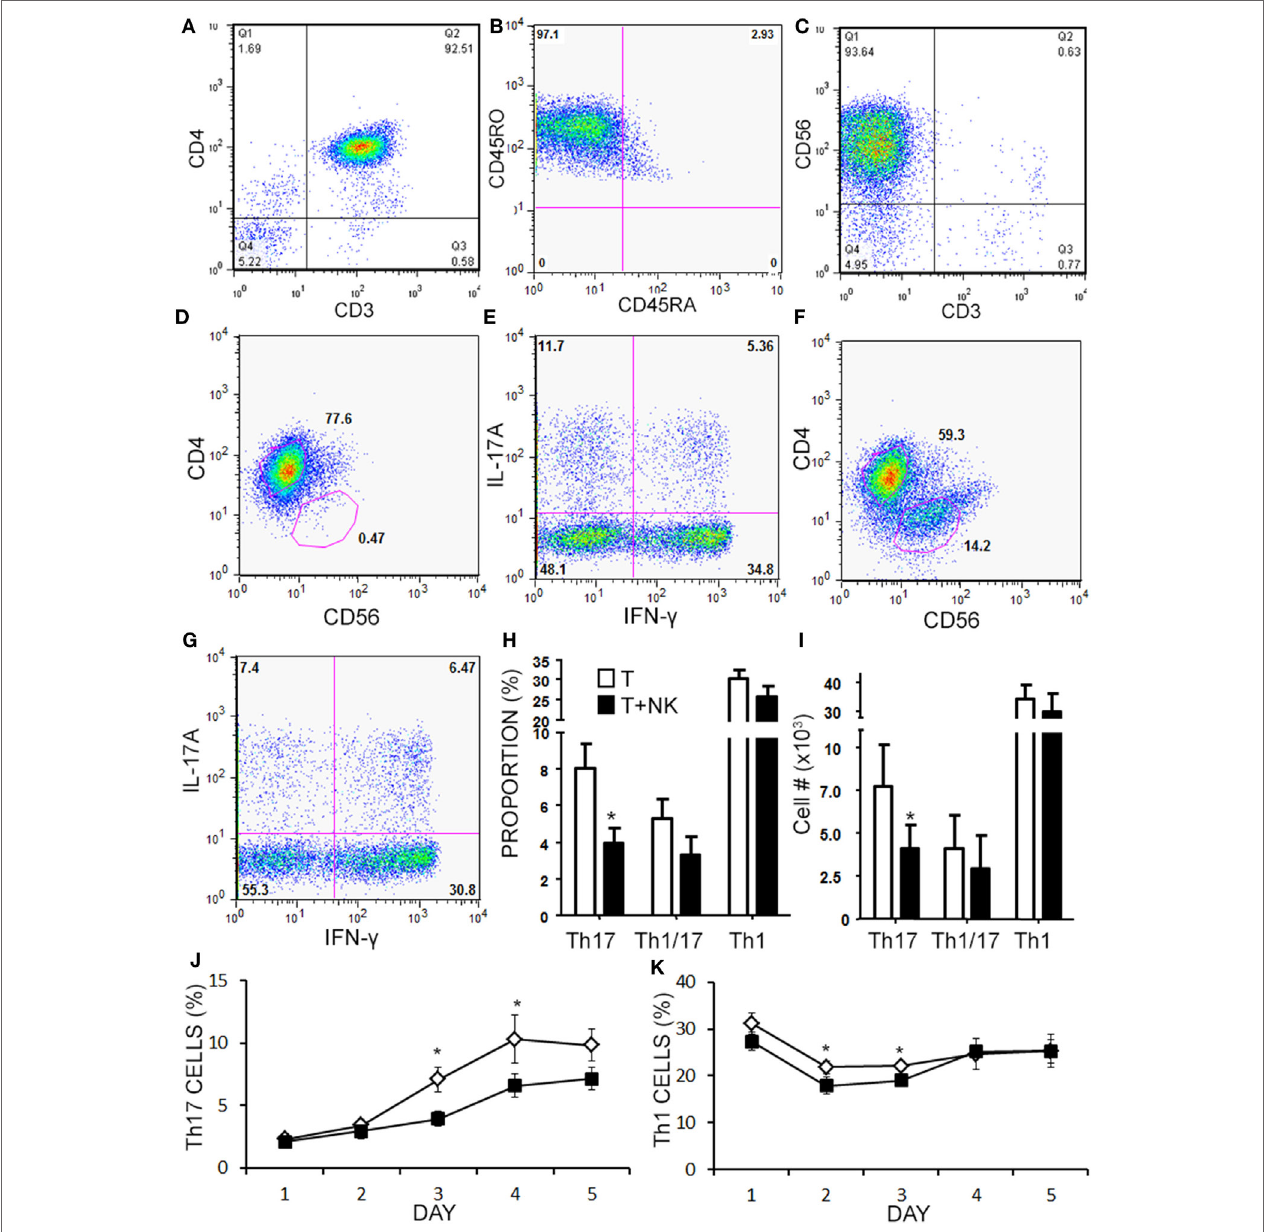
FigUre 5 | Natural killer (NK) cells reduce the proportion of Th17 and Th1 cells in vitro . Memory CD4 + T cells and NK cells were isolated from healthy subject PBMC. Memory CD4 + T cells were CD3 + CD4 + CD45RO + CD45RA − as shown in representative dot plots (a,B) . NK cells were CD3 − CD56 + as shown in a representative dot plot (c) . Memory CD4 + T cells were cultured without (D,e) , or with NK cells at a 1:1 ratio (F,g) for 4 days with anti-CD3, anti-CD28, and Th17 polarizing factors for 4 days. Plots are shown for CD4 × CD56, which was used to gate CD4 + helper T (Th) cells. Expression of IL-17 and IFN- γ by CD4 + T cells was assessed by intracellular flow cytometry (Th17 = CD3 + CD4 + IL-17A + IFN- γ − , Th1 = CD3 + CD4 + IL-17A − IFN- γ + , and Th1/17 = CD3 + CD4 + IL-17A + IFN- γ + ). Data pooled from 12 experiments showing the proportion (h) and absolute number of Th cells (i) . A time-course analysis for Th17 cells (J) and Th1 cells (K) was performed for 5 days using intracellular cytokine staining. Open diamond = T cells and closed square = T cells + NK